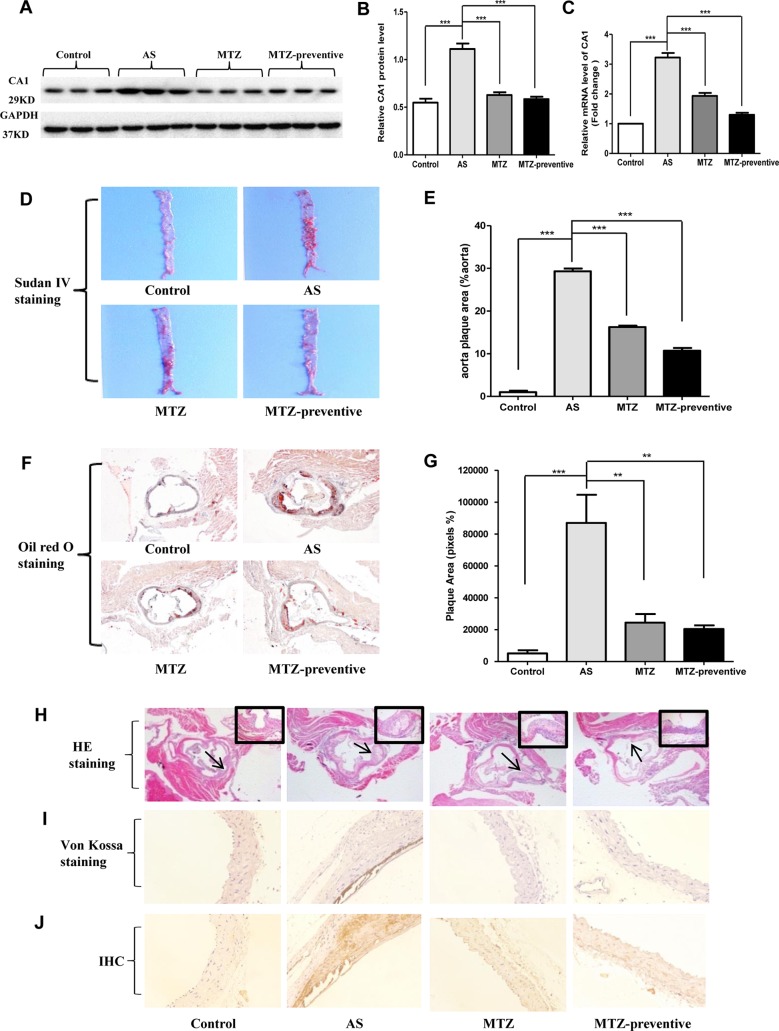
Changes in histopathological structure, calcification, and CA1 expression in aortas from AS mice treated with MTZ. (A) CA1 protein expression in mouse model aortas using Western blot analysis. (B) Semiquantification of CA1 protein expression in mouse model aortas (ANOVA, P < 0.001). (C) CA1 transcription in aortas from the mice using real-time PCR (ANOVA, P < 0.001). (D) Sudan IV staining. (E) Semiquantification of atherosclerotic lesion area of AS mice (ANOVA, P < 0.001). (F) Oil Red O staining (40X magnification). (G) Semiquantification of atherosclerotic lesion area of the aortic root (ANOVA, P < 0.001). (H) Hematoxylin and eosin (HE) staining (40X magnification, the area indicated by the arrow is shown in the top right corner at 200X magnification). (I) Von Kossa staining (200X magnification). (J) Immunohistochemistry of CA1 (200X magnification). N = 5 for each group. Data are shown as the means ± SEM. **P < 0.01, ***P < 0.001.